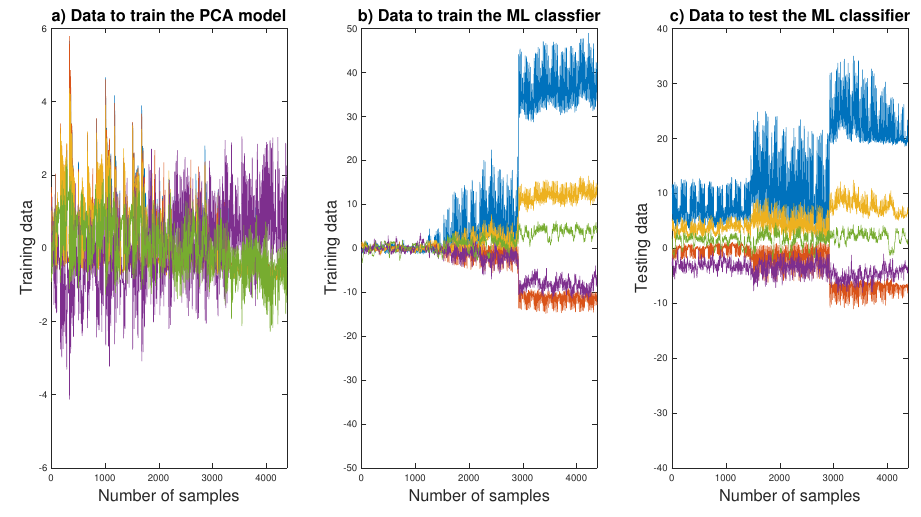
Figure 4. Data generation of air conditioning systems